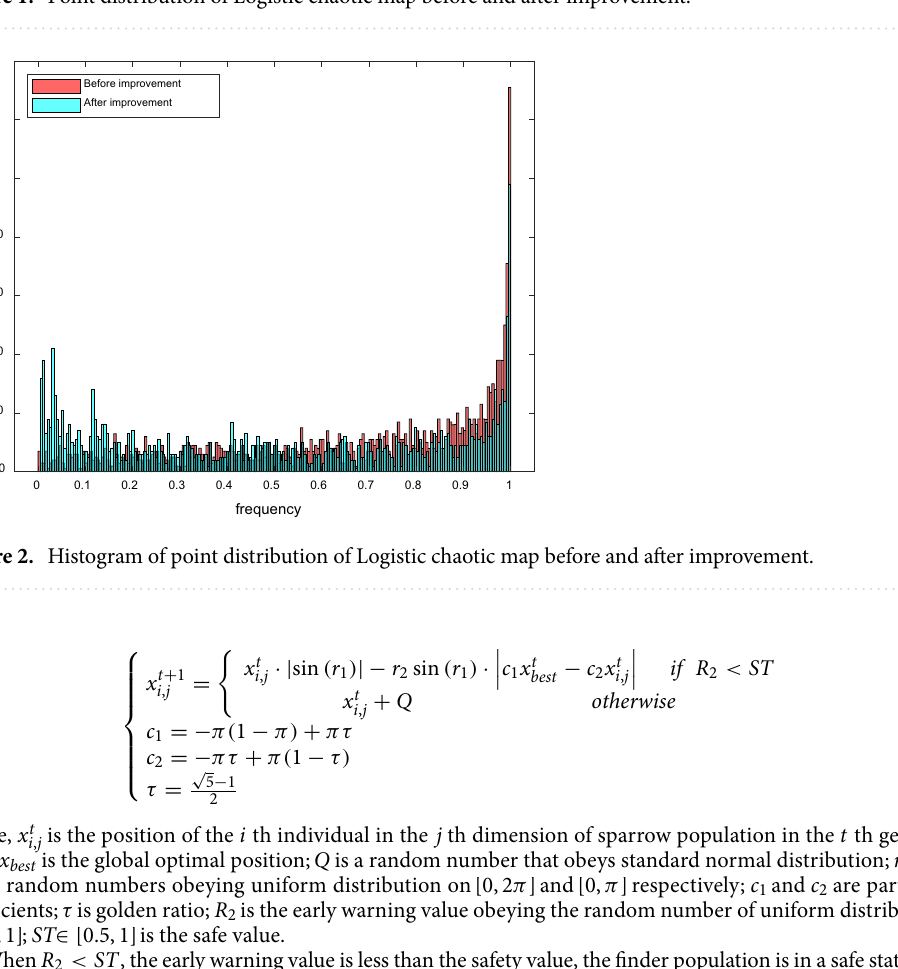
Figure 1. Point distribution of Logistic chaotic map before and after improvement.